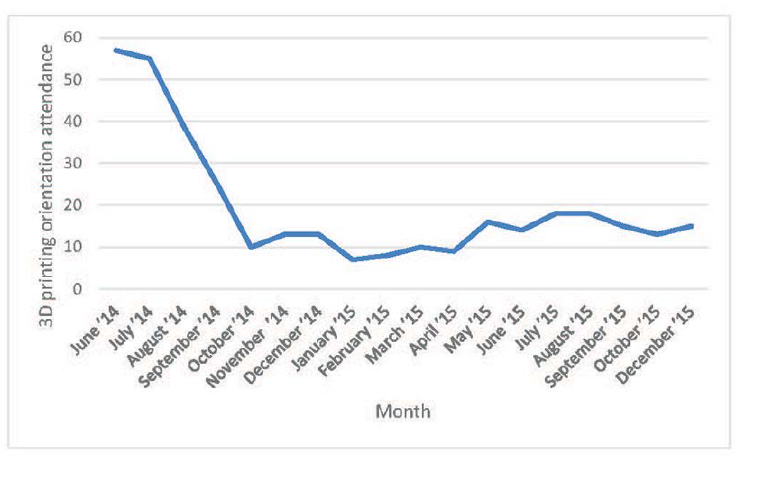
Figure 1 Attendance at 3D printing